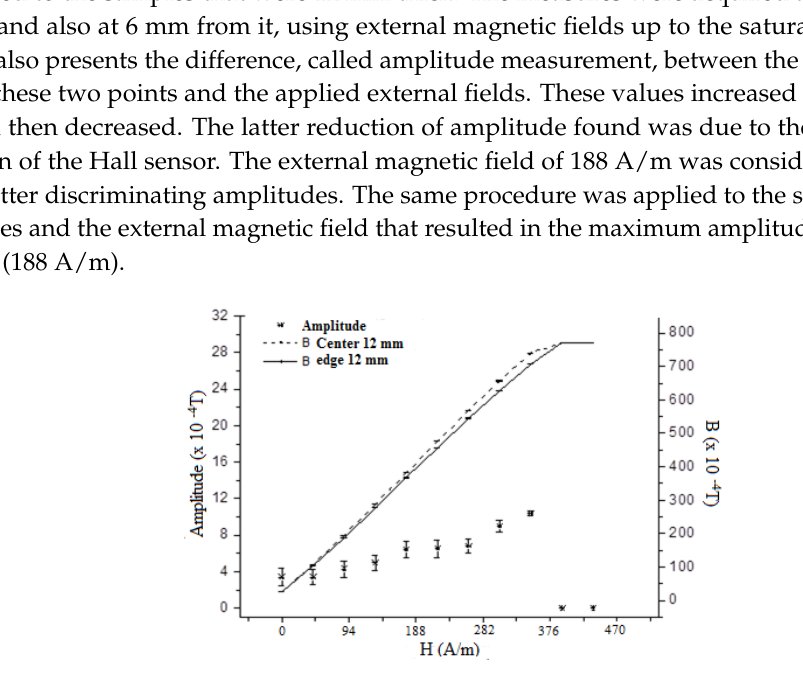
Figure 3. Changes of the induced magnetic field (B) and amplitude versus the external magnetic field (H) applied to the samples that were 12 mm thick.